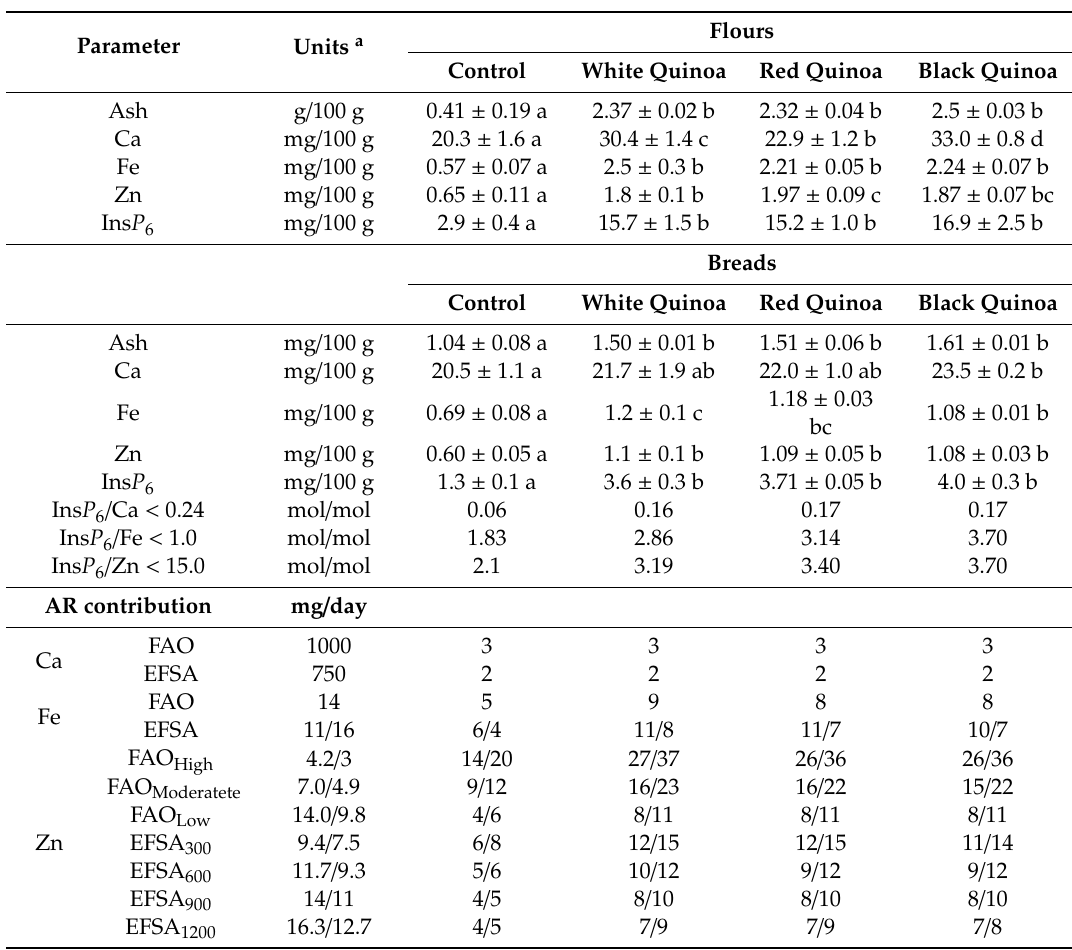
Table 3. Mineral (Fe, Ca, Zn) content, phytate level ratio in raw materials and breads, phytate / mineral molar ratio and average requirement